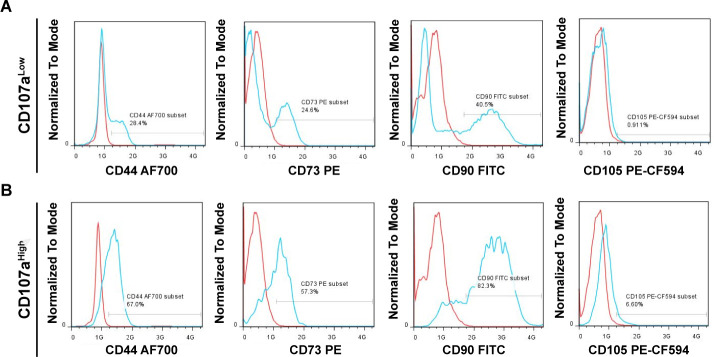
Flow cytometry of canonical human mesenchymal stem cell (MSC) markers among freshly isolated CD107alow/high cells from a representative patient sample.(A, B) Expression of CD44, CD73, CD90, and CD105 within (A) CD107alow and (B) CD107ahigh cells. Frequency of expression is shown in relation to isotype control antibody (blue vs. red lines). Corresponding tabular data from N = 3 human samples is shown in Supplementary file 4.